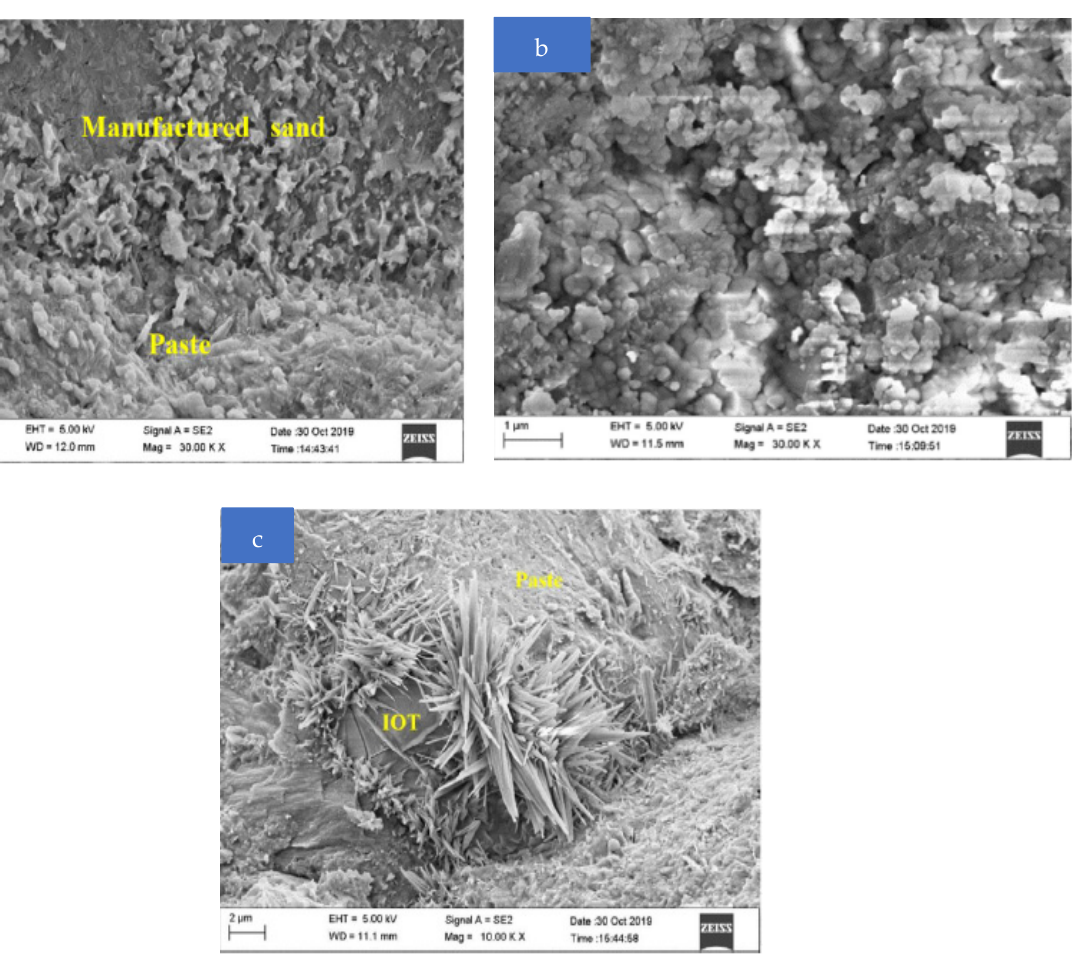
Figure 15. SEM results: ( a ) control; ( b ) 40% IOT; ( c ) 100% IOT (used with permission, Elsevier Figure 15. SEM Results: Used as per Elsevier Permission (a) Control, (b) 40% IOT and (c) 100% IOT 391 [47] 392 . 393